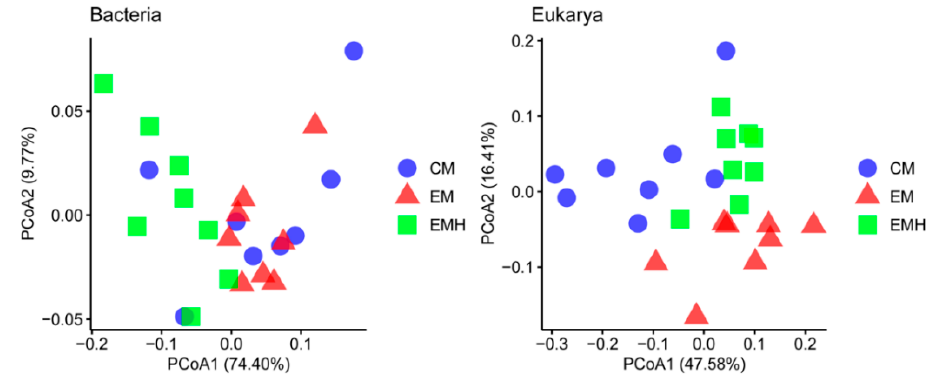
Figure 5. Principal coordinate analysis (PCoA) based on Bray–Curtis distances showing the differences in predicted functional profiles among the three farming systems.